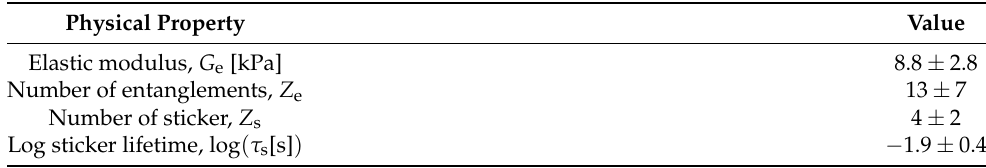
Table 2. Physical parameter values obtained by fitting the sticky-reptation model to the elastic